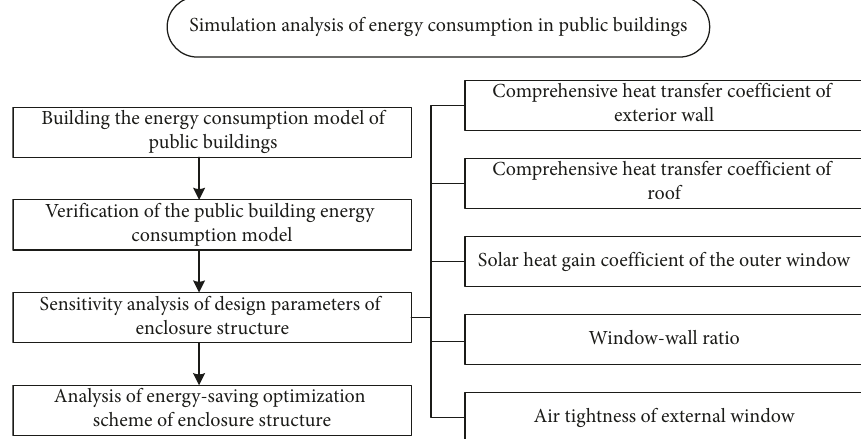
Figure 1: Technical